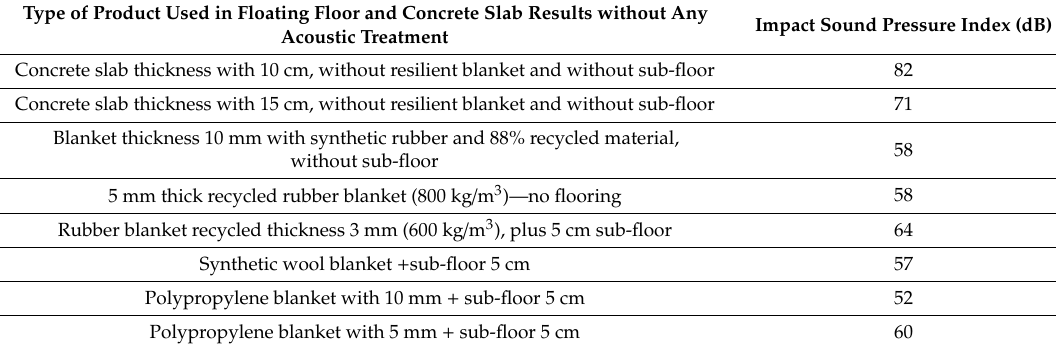
Table 14. Indicative values of weighted standardized impact sound pressure index, L’